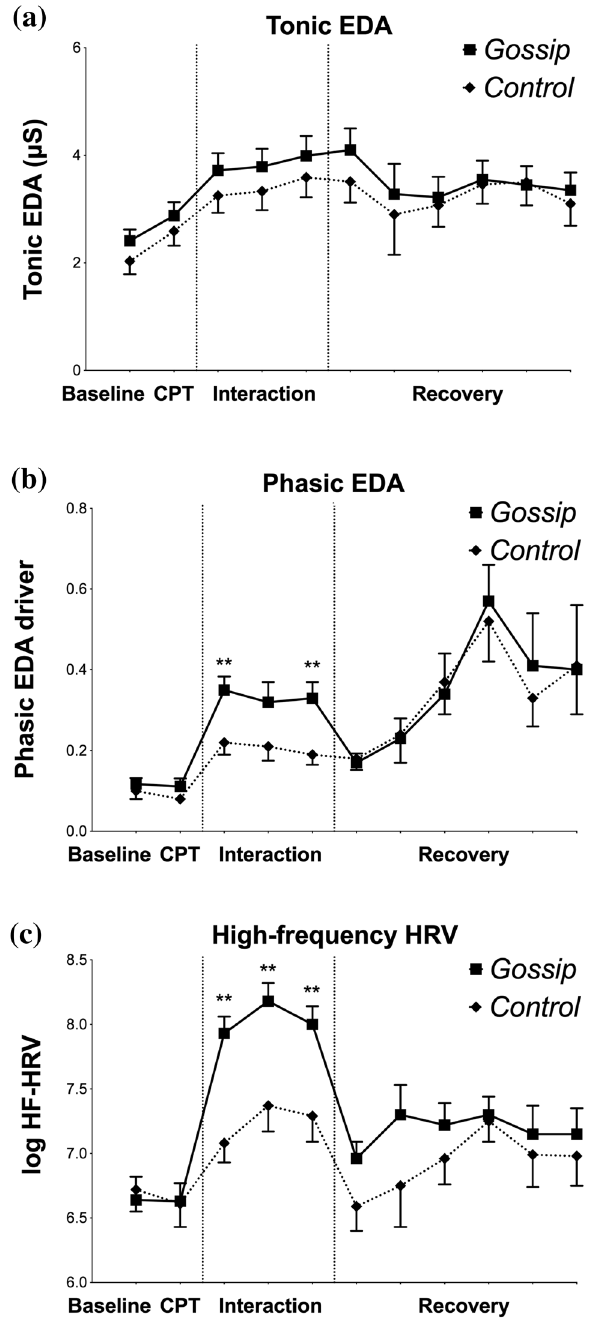
Figure 3. Changes in participants’ autonomic activity during the experiment. Vertical dotted lines mark the beginning and end of the social interaction. Each datapoint represents a 5-min epoch, with the exception of CPT, which lasted 3 min. EDA— Electrodermal Activity, CPT-Cold Pressor Test, HF-HRV—High Frequency Heart Rate Variability. * p < 0.05, ** p < 0.01 , error bars: ± SEM. Asterisks without the brackets indicate that at that timepoint gossip condition significantly differed from the control